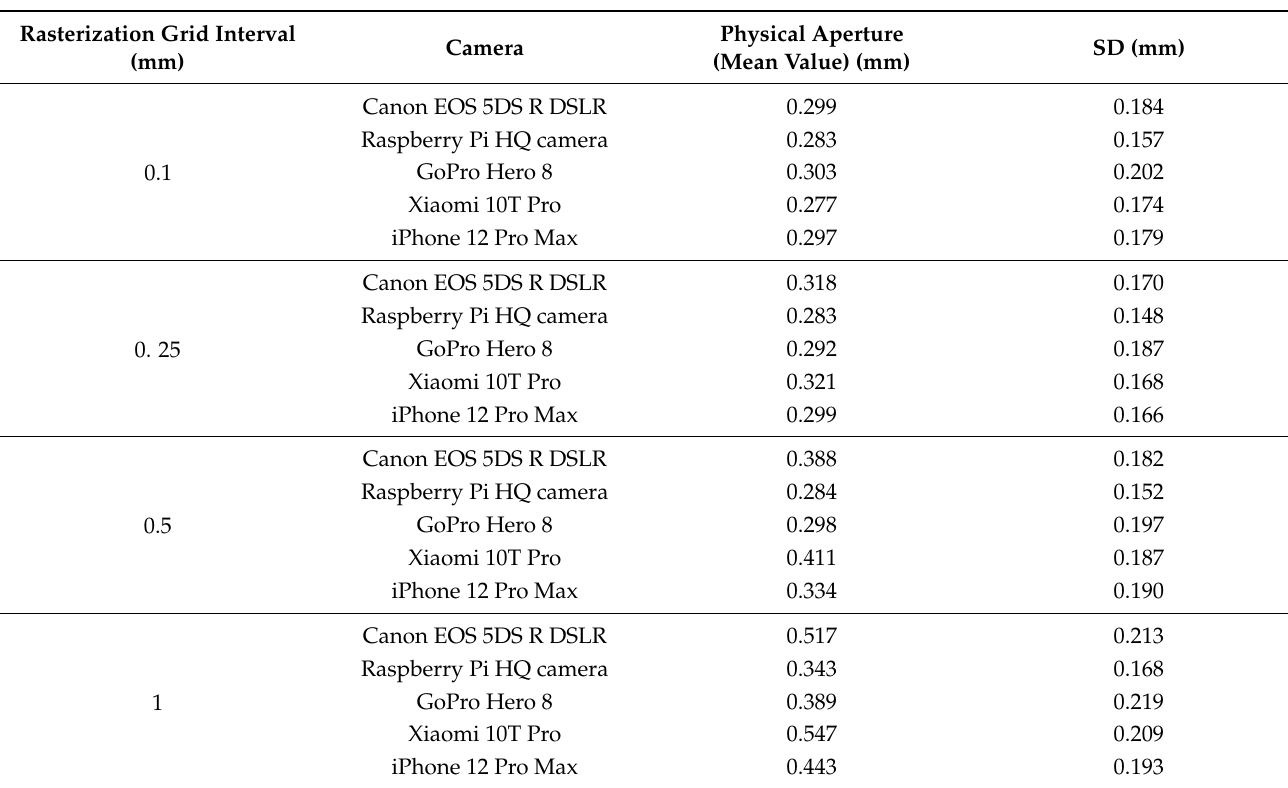
Figure 10. Comparison of estimated physical apertures obtained by all cameras for different rasterization grid intervals. Table 7. Measured physical aperture using different grid intervals.